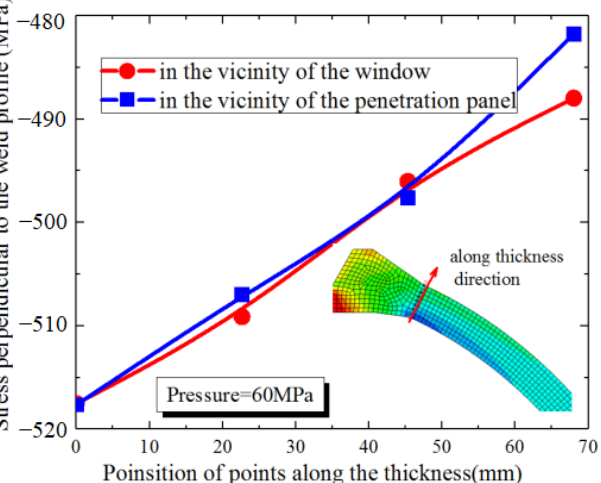
Figure 3. The circumferential stress distribution along the pointed paths under pressure of 60